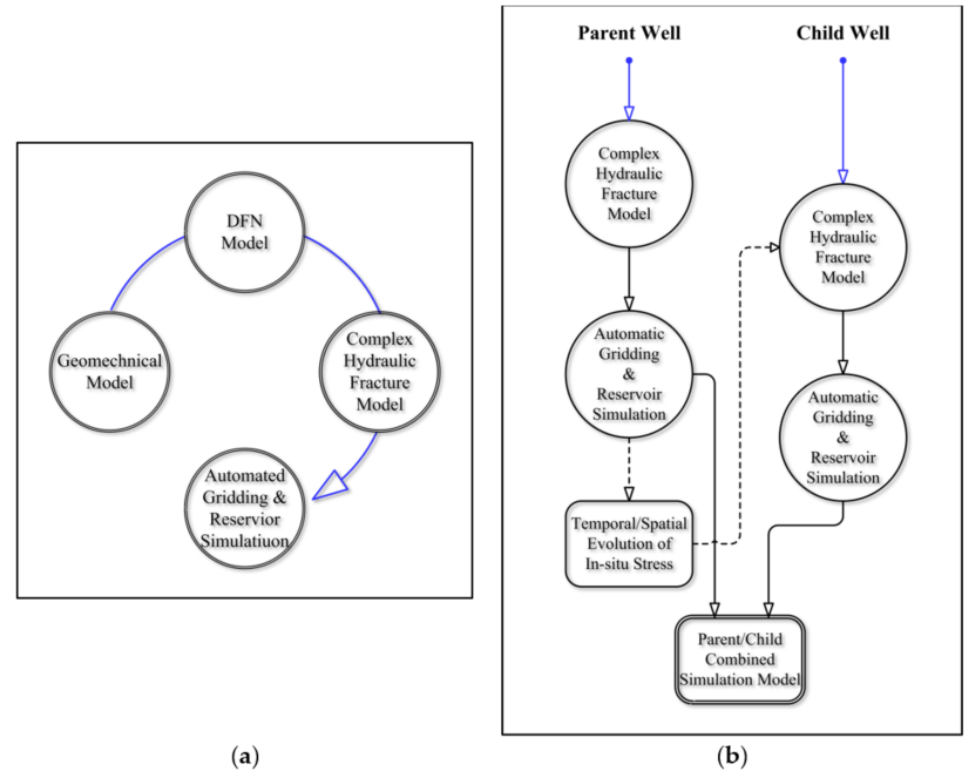
Figure 4. ( a ) Simplified complex hydraulic fracture/reservoir geomechanics modeling workflow; ( b ) expanded workflow used to model parent/child well fracture interference.